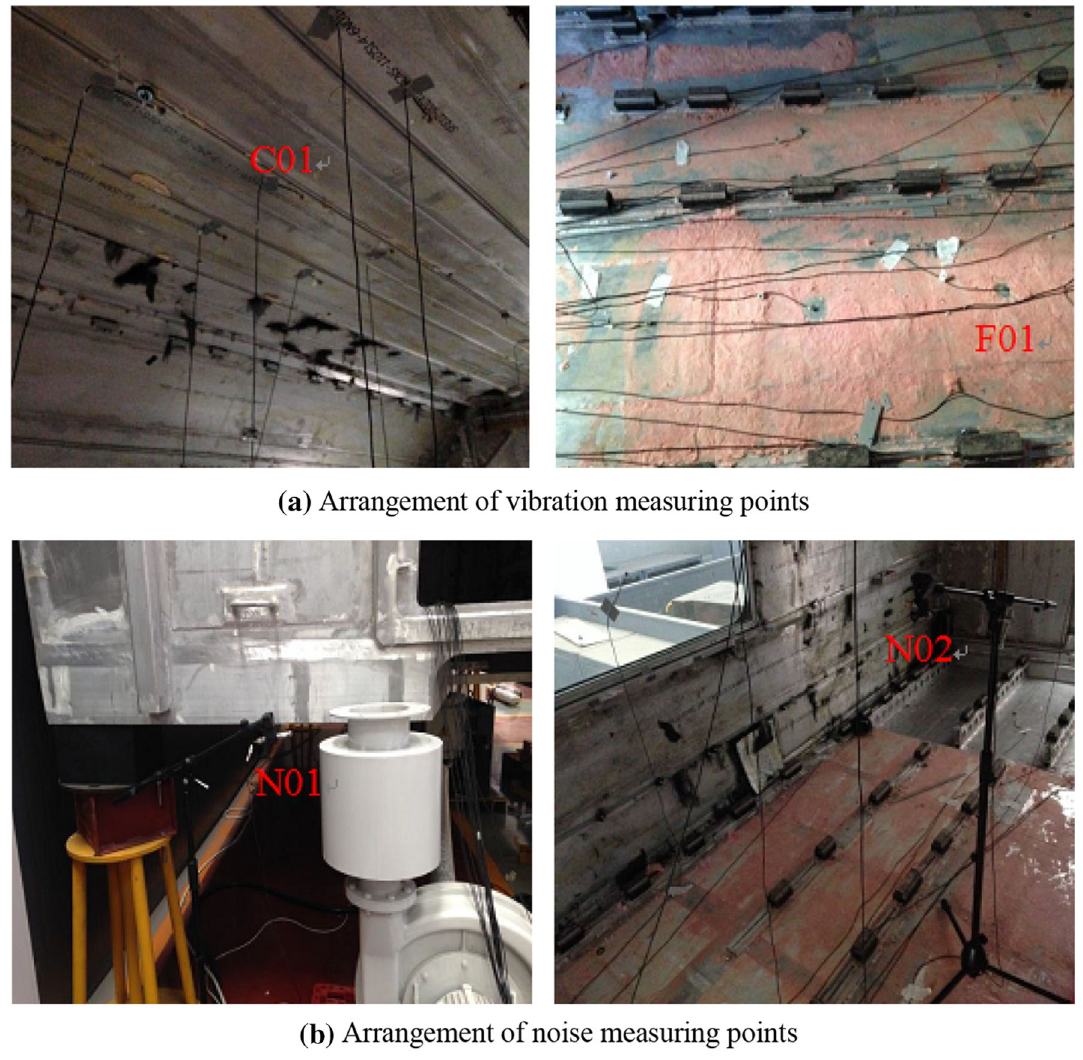
Fig. 7 Measuring points of vibration and noise test (C01: vehicle top, F01: vehicle floor, N01: outside of the vehicle, N02: inside of the